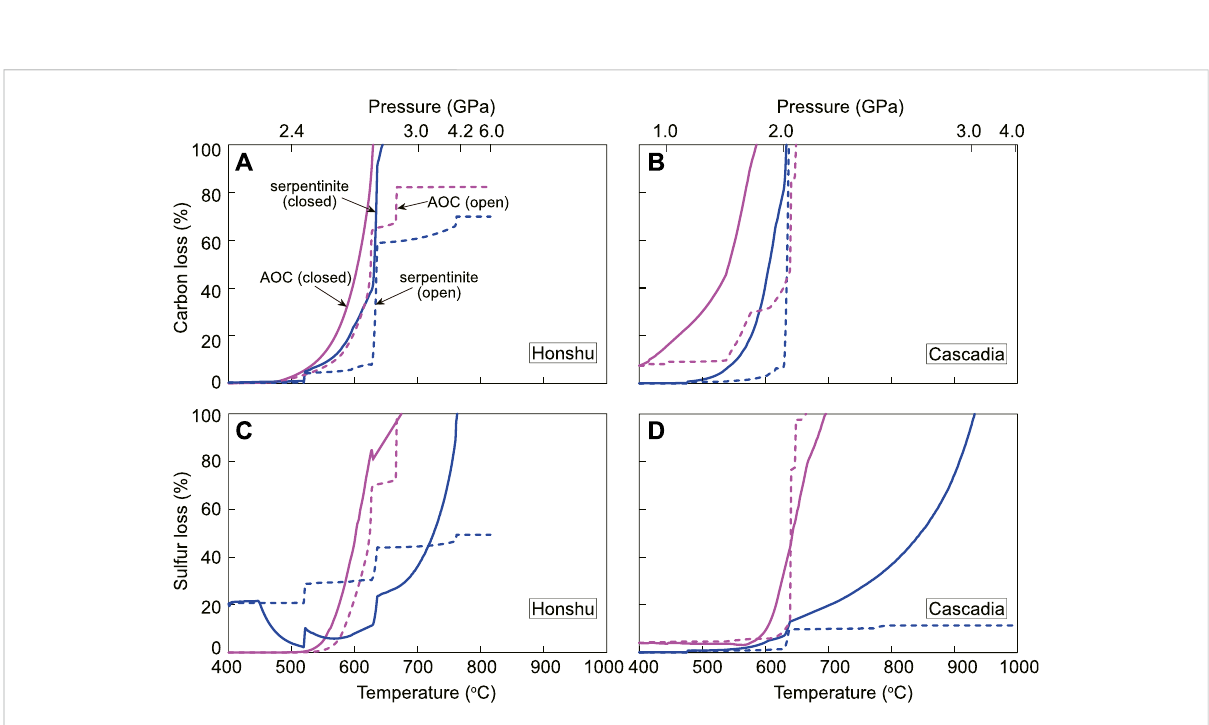
FIGURE 6 Plots of carbon and sulfur loss (carbon loss/initial carbon concentrations and sulfur loss/initial sulfur concentrations) calculated along the Honshu (A,C) andCascadiageotherms (B,D) .ThecoloredlinesrepresentAOC(pink)andserpentinite(blue)systemsbyassumingaclosed (solidline) and open (dashed line) system,